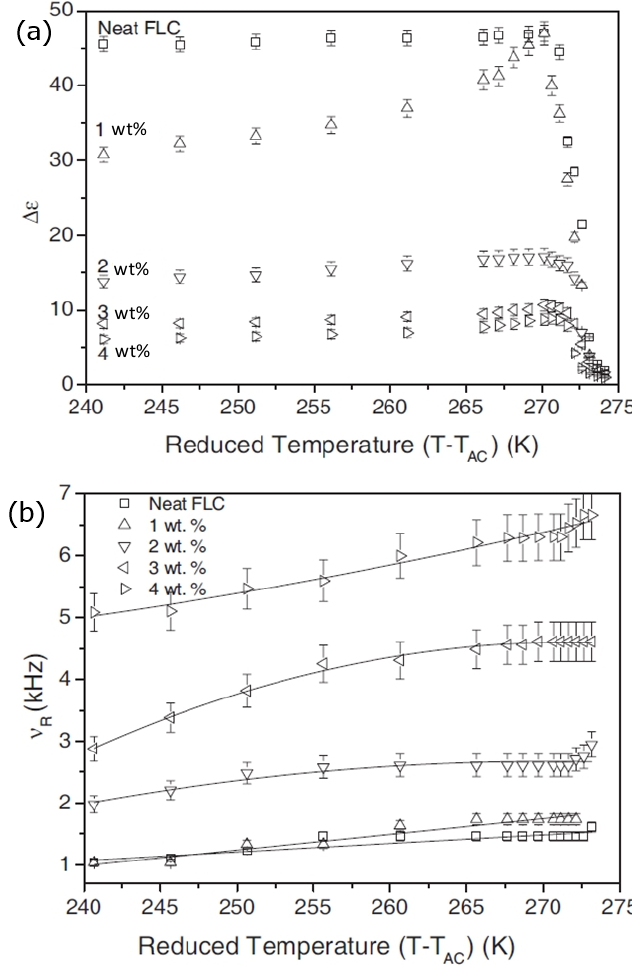
Figure 11. ( a ) The dielectric strength of the Goldstone mode is suppressed for increasing polymer concentration; while ( b ) the relaxation frequency increases with increasing network density. (Reproduced with permission from [58]. Copyright 2009 EDP